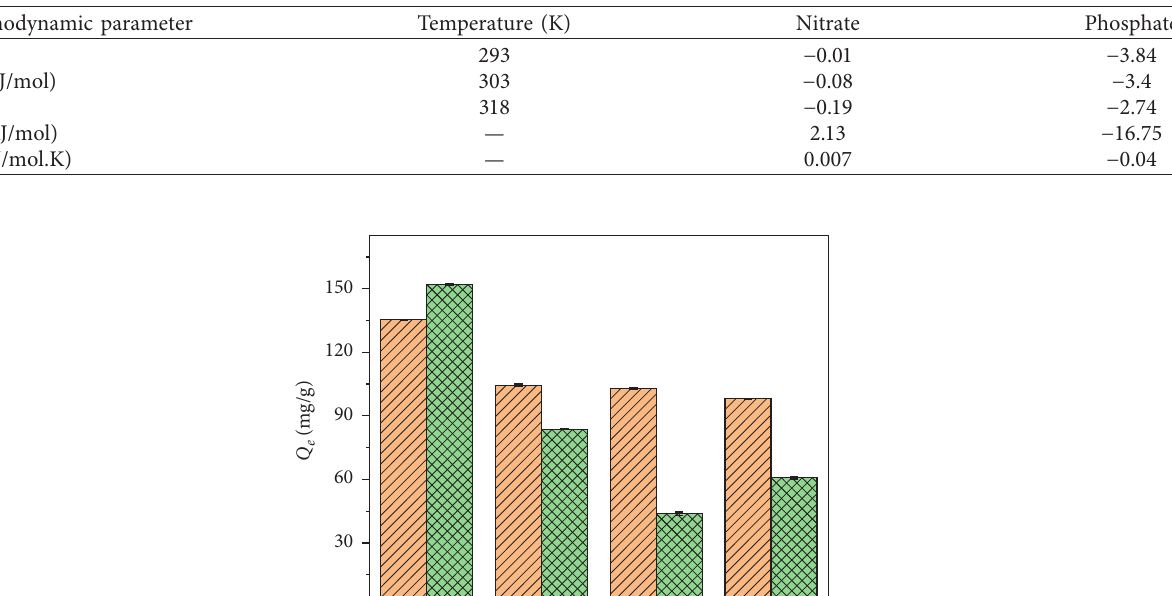
Table 4: Thermodynamic parameters of nitrate and phosphate adsorption onto ferric oxide-amine material at different temperatures.